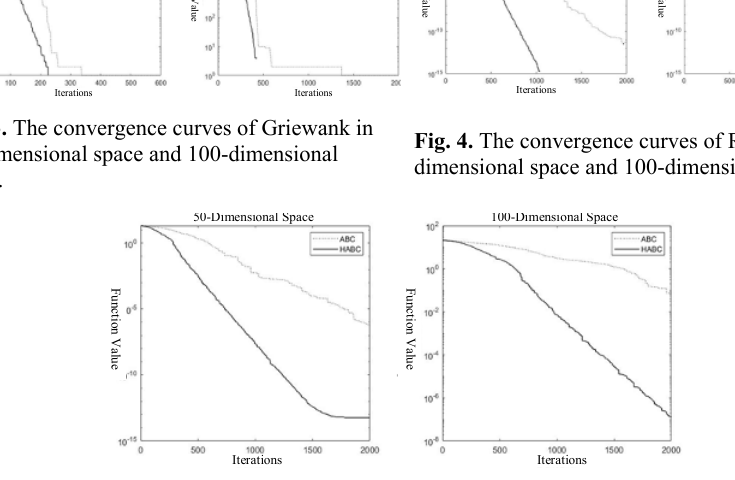
Fig. 5. The convergence curves of Ackley in 50-dimensional space and 100-dimensional